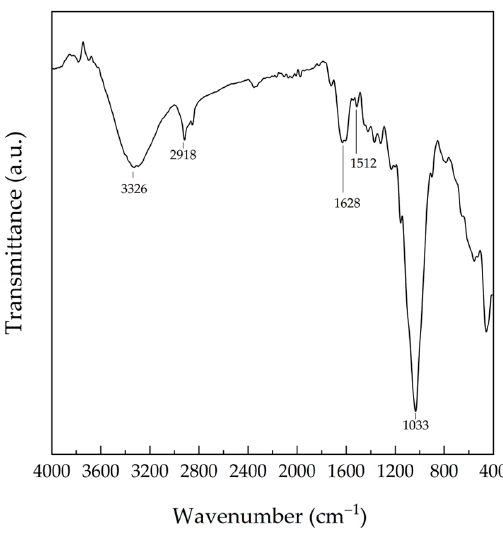
Figure 15. FTIR spectra of BLF.